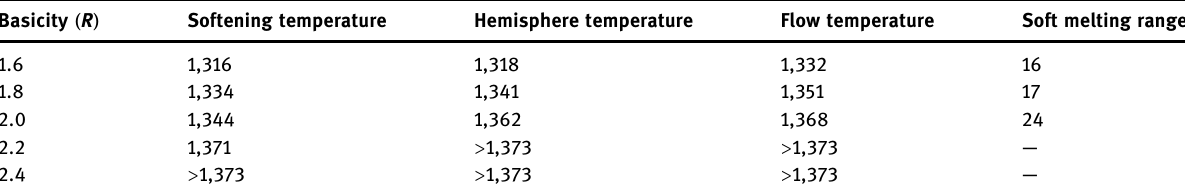
Table 11: Test results of melting point of mixed slag with di ff erent basicity/°C Basicity ( R )